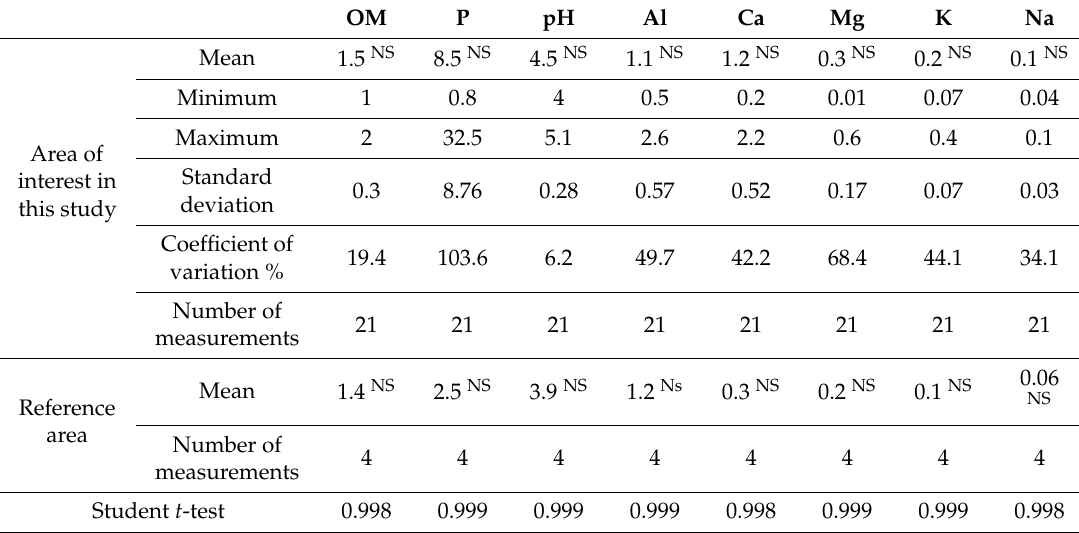
Table 1. Descriptive statistics and Student t -test mean difference analysis of the area of interest and the reference area for organic matter (OM, %), available phosphorus (P, ppm), pH, aluminum (Al, meq/100 g soil), and the exchangeable bases calcium (Ca), magnesium (Mg), potassium (K), and sodium (Na) meq/100 g